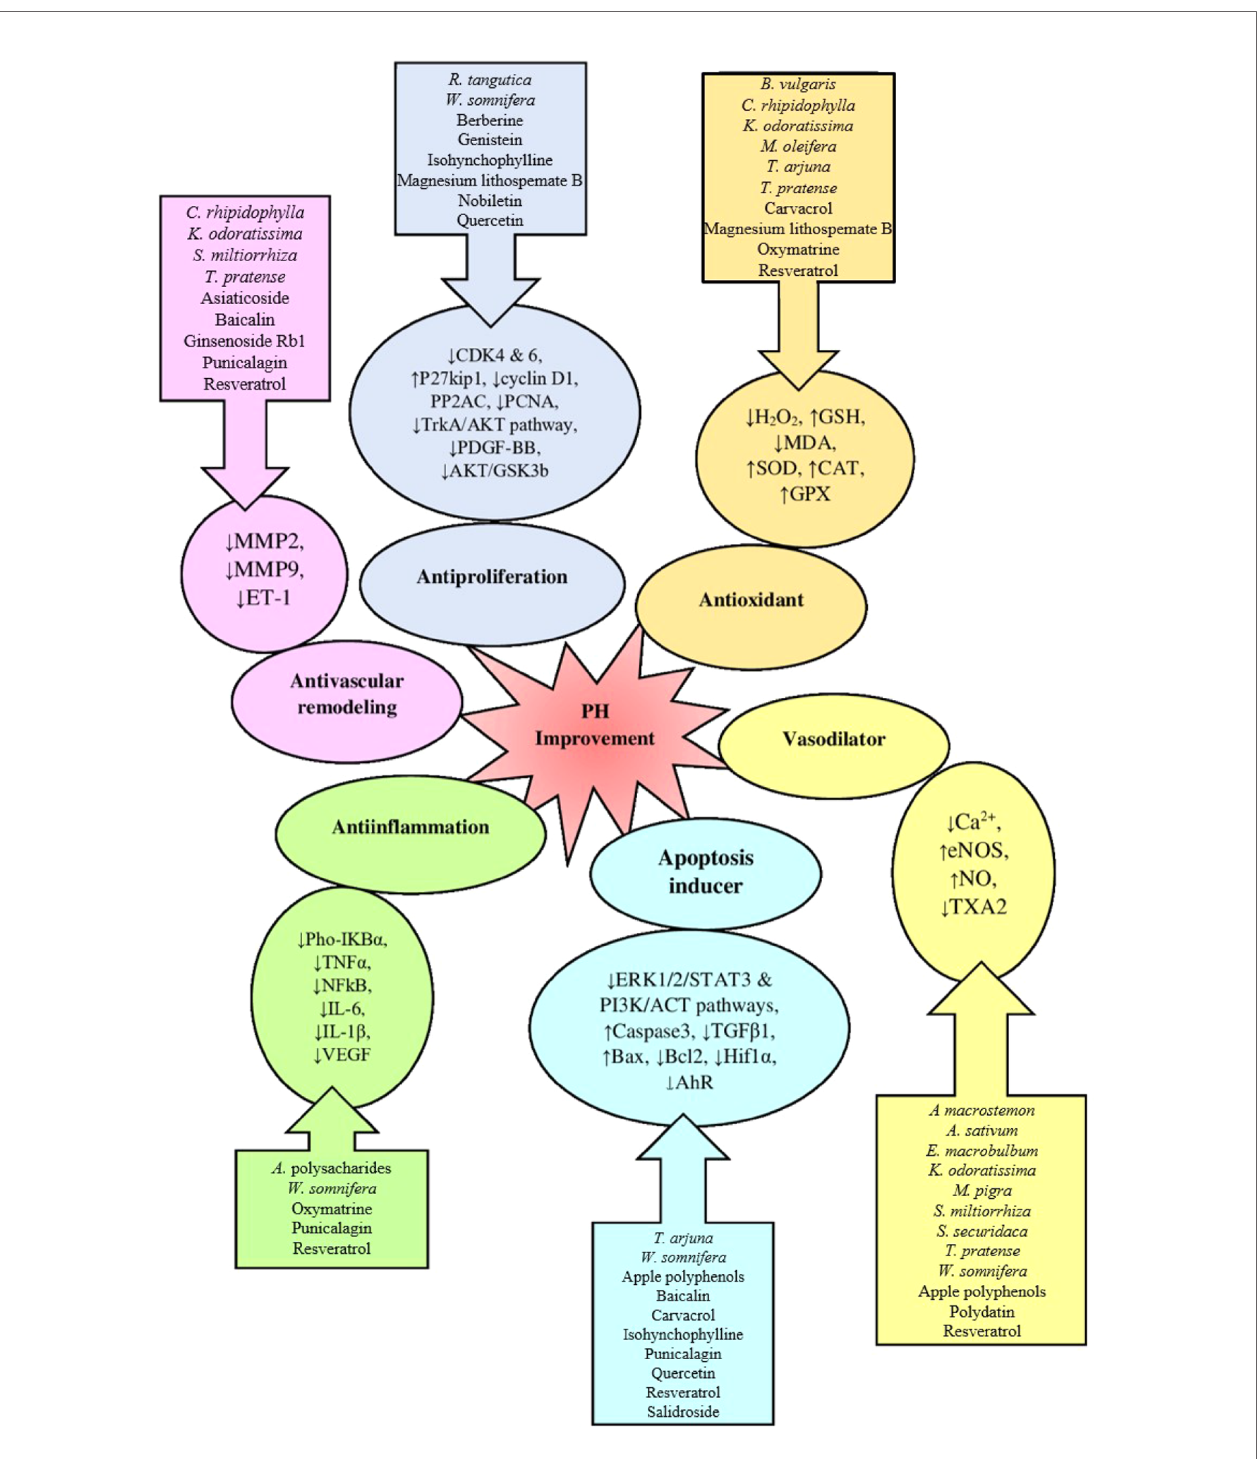
FIGURE 2 | The summary of 6 pathways that leads to PH